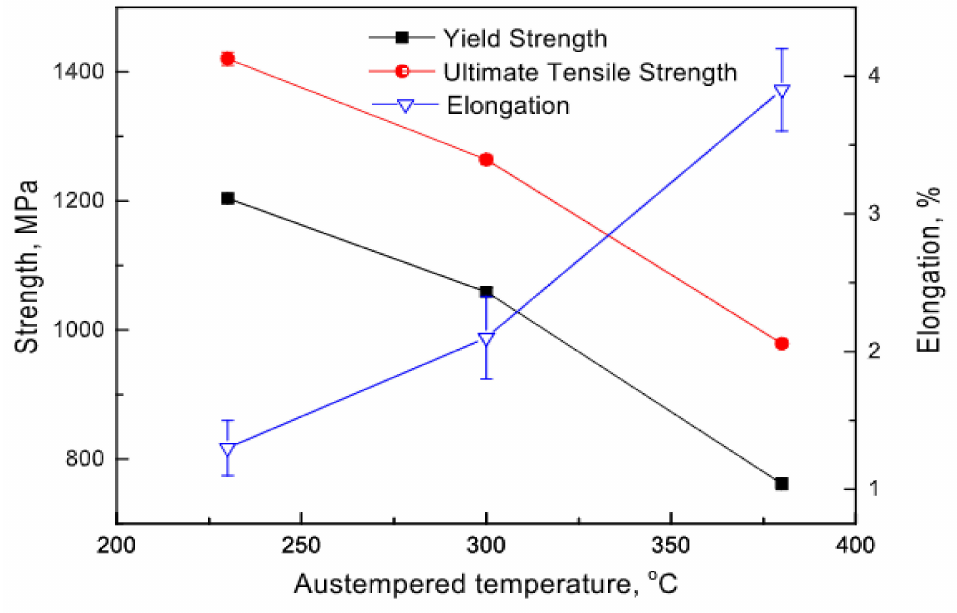
Figure 39. The mechanical variable at different austempered temperatures